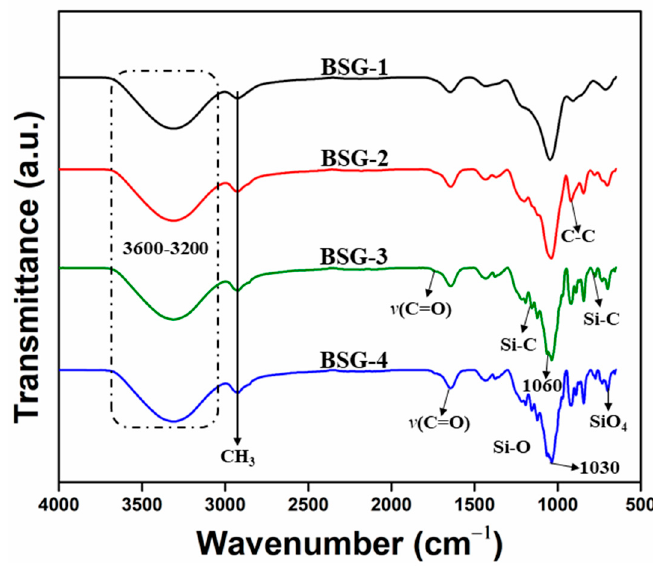
Figure 1. FTIR spectra of composite hydrogels to determine the structural, and functional groups and their physicochemical interactions.